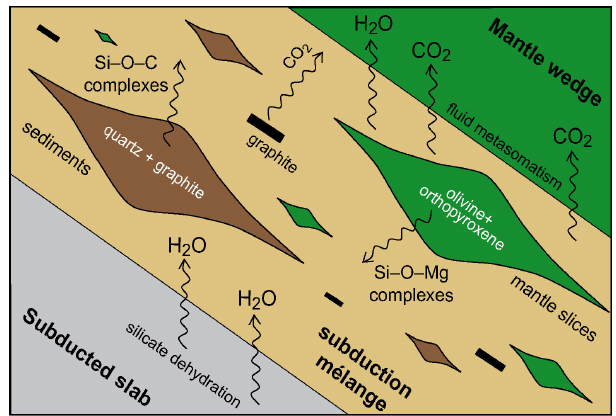
Figure 6. Cartoon showing a subduction mélange modified from Tumiati et al. (2017). The aqueous fluids released from the sub- ducted slab interact with slices of mantle-derived rocks (forsterite + enstatite) and sedimentary slab cover (quartz + graphite). Silicates dissolution in GCOH fluids and the consequent release of organosil- icon complexes enhance the CO 2 content in the fluid. These CO 2 - and solute-rich fluids will subsequently interact with the mantle wedge, prompting metasomatic